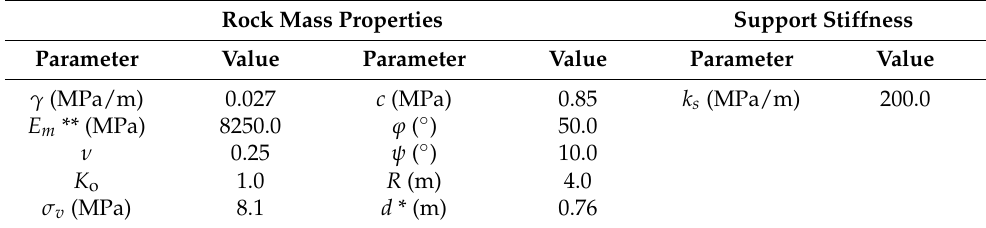
Table 4. Input data of the numerical computation of ICM and Oreste (2009) [19]. Rock Mass Properties